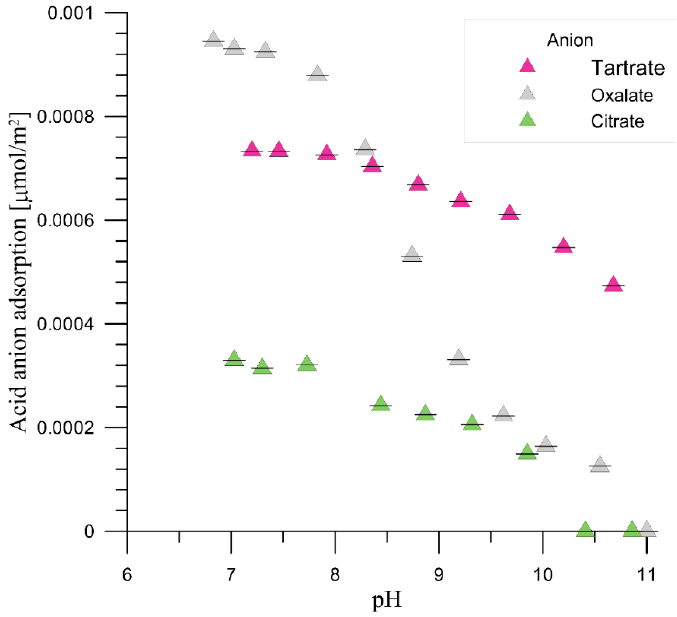
Figure 3. Oxalate, citrate and tartrate ion adsorption in the hydroxyapatite/0.001 mol/dm 3 NaCl solution system as a pH function. The initial concentration of oxalate, citrate or tartrate ions was 0.000001 mol/dm 3 .